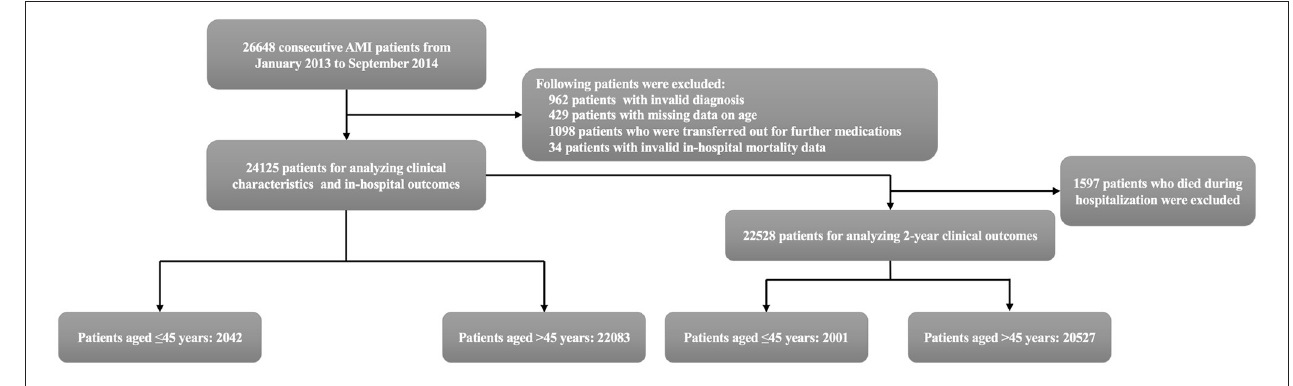
FIGURE 1 | Flowchart of this study. AMI, acute myocardial